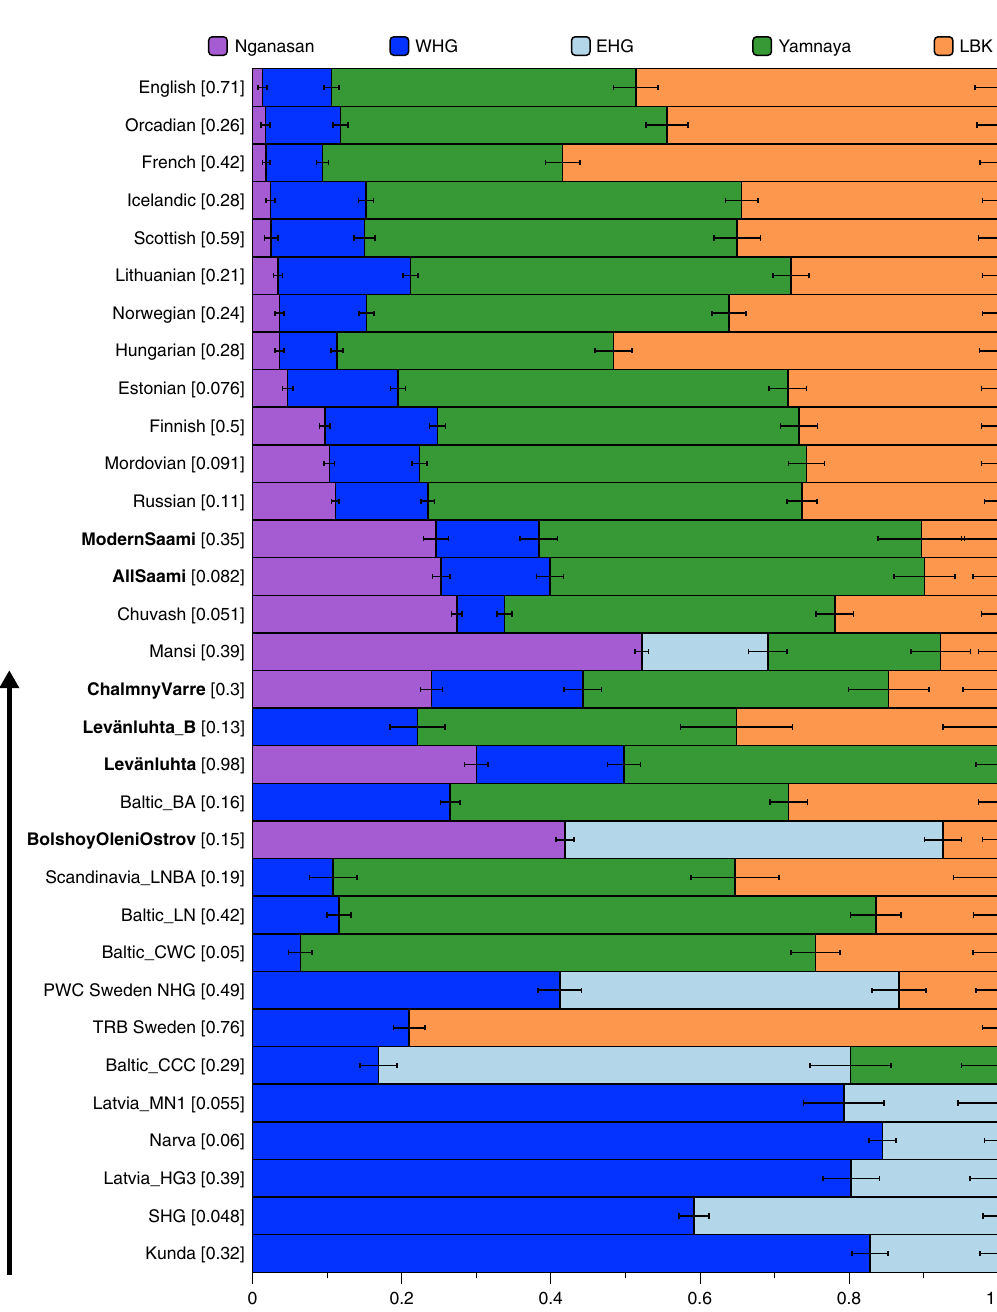
Fig. 4 Mixture proportions from fi ve sources estimated using qpAdm. Sources used were Nganasan, WHG, EHG, Yamnaya and LBK (see Methods/ Supplementary Data 4). P -values (chi-square) for each model are shown in square brackets next to the test population. Results from the least complex model for each test population/individual are shown. “ AllSaami ” corresponds to a population consisting of the two genomes from the SGDP and the genome from this study (ModernSaami). Error bars represent one standard error and are plotted to the right of their associated mixture proportion. Populations containing individuals from this study are shown in bold. Source data are provided as a Source Data fi